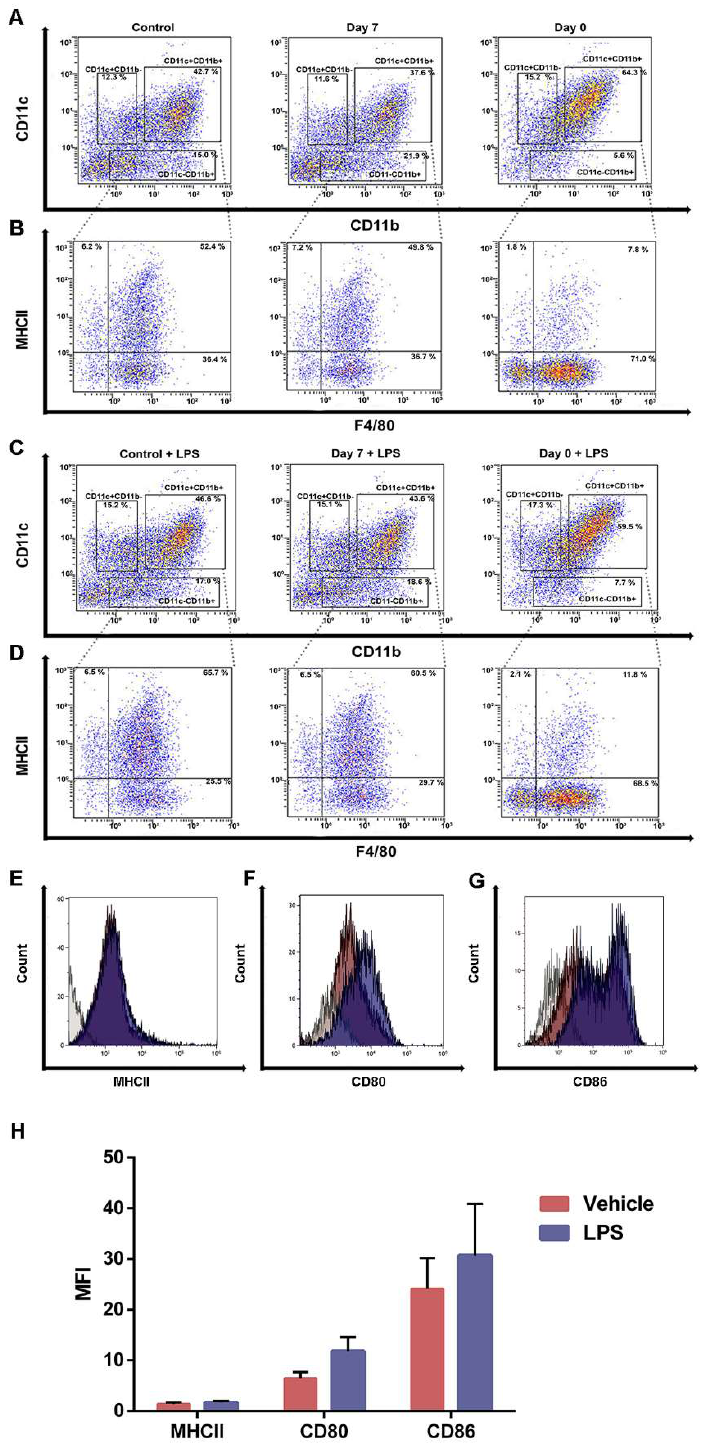
Figure 4. Iron blocks BMDCs maturation and generates CD11c + CD11b + F4 / 80 + MHCII low cells. Representative density plots and histograms of BMDCs cultured in iron-overload condition for seven days or for 24 h ( A , B ). BMDCs cultured in iron-overload mimicking condition for seven days or for 24 h were exposed to LPS for 24 h ( C , D ). Cells cultured in iron-overload mimicking condition for seven days were treated with vehicle or LPS and analyzed by FACS 24 h later ( E – H ). Histograms represent MHCII ( E ), CD80 ( F ), and CD86 ( G ) CD11c + CD11b + F4 / 80 + MHCII low cells surface expression. Bar plot showing the (Mean fluorescence index) MFI of MHCII, CD80, and CD86 ( H ).